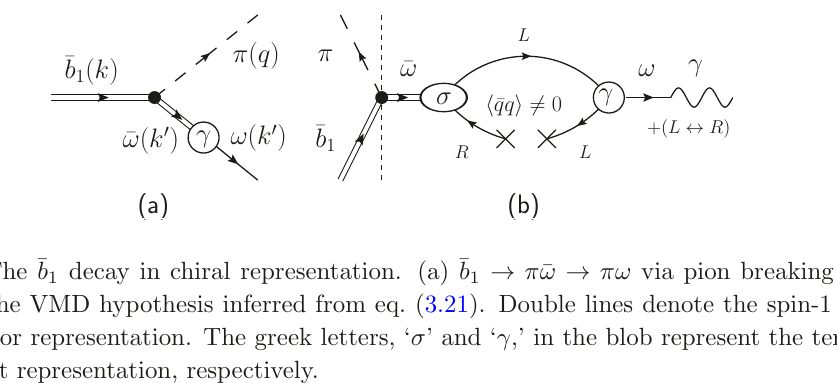
π ¯ ω πω via pion breaking and (b) → →